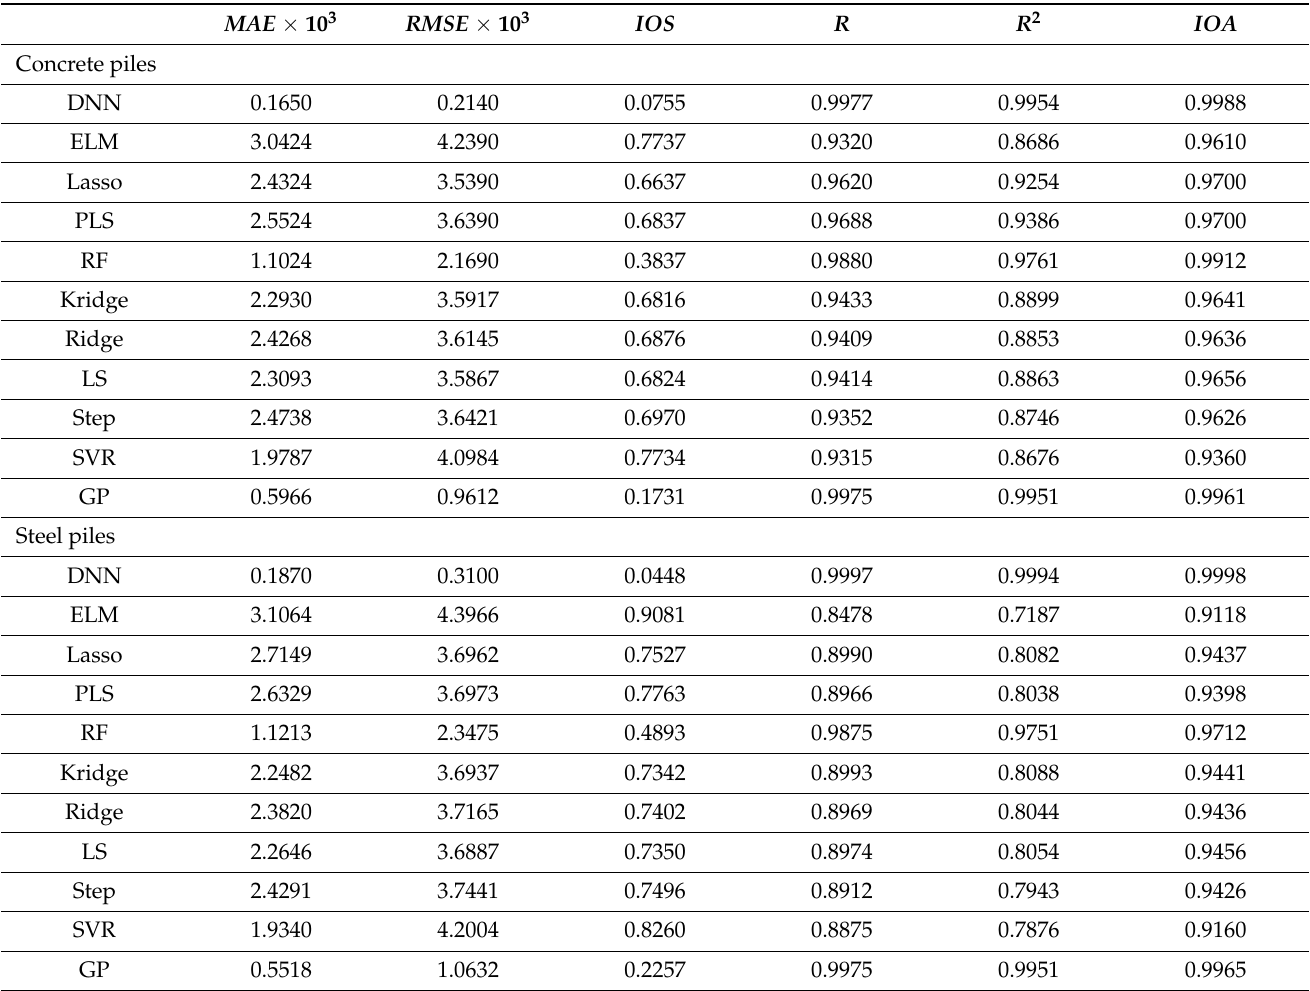
Table 6. Performance indicators values of the AI models for predicting the pile-bearing capacity in both concrete and steel piles (bold: the optimal